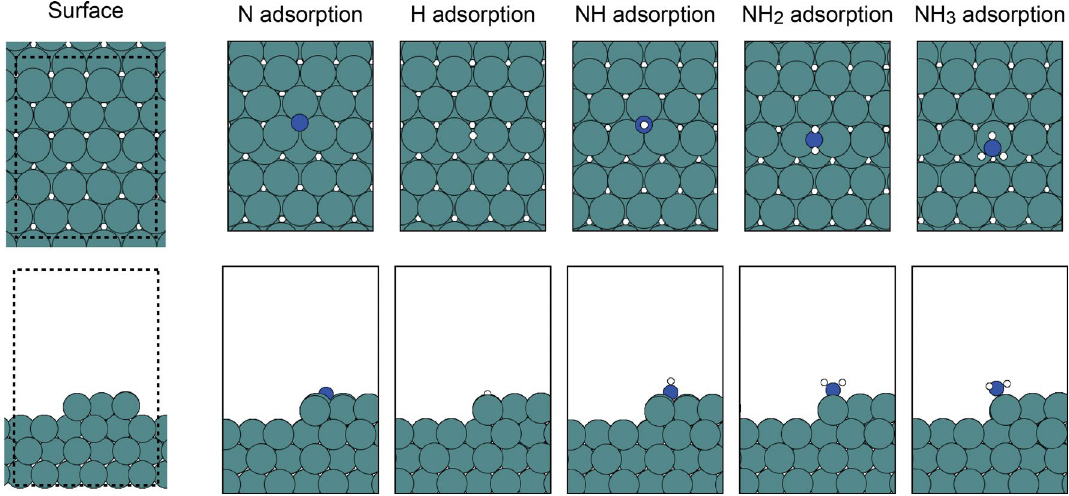
Figure 1. Typical slab model for the stepped surface. The adsorption sites of the N, H, NH, NH 2 , and NH 3 species are also provided. The upper and lower panels show the top and side views. The dotted line in the bare surface model indicates the boundary of the supercell. The metal, N, and H atoms are represented by green, blue, and white spheres,